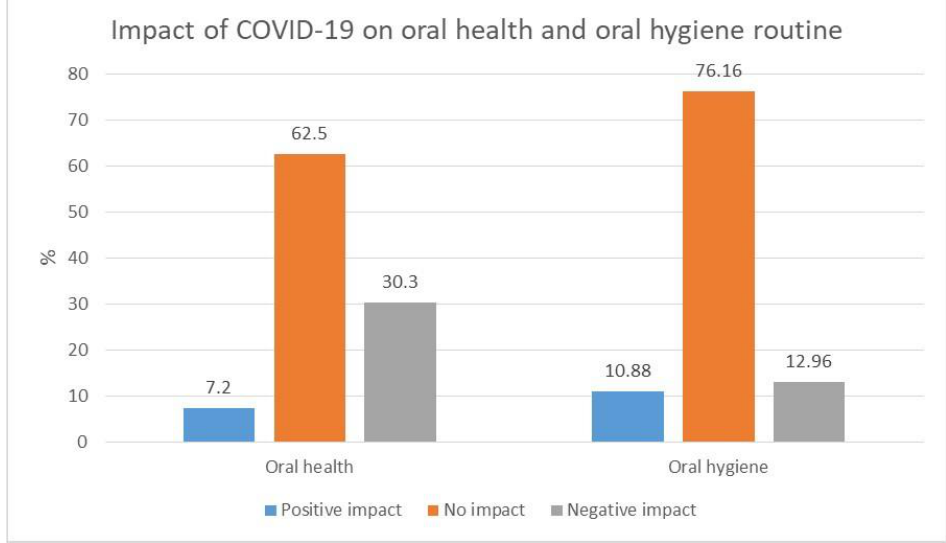
Figure 1 Impact of COVID-19 outbreak on respondents’ oral health and oral hygiene